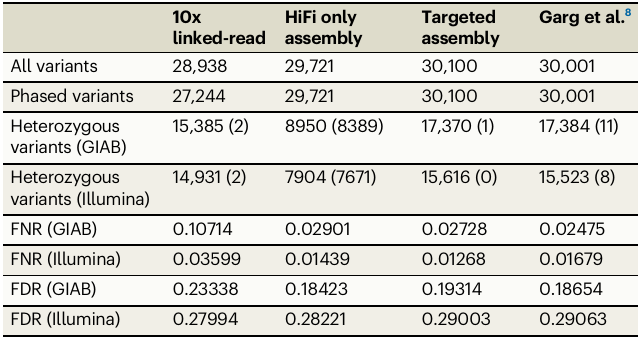
Table 1 | Genetic variants called from 10x Genomic linked- read data and the assembled haplotypes 10x HiFi only linked-read